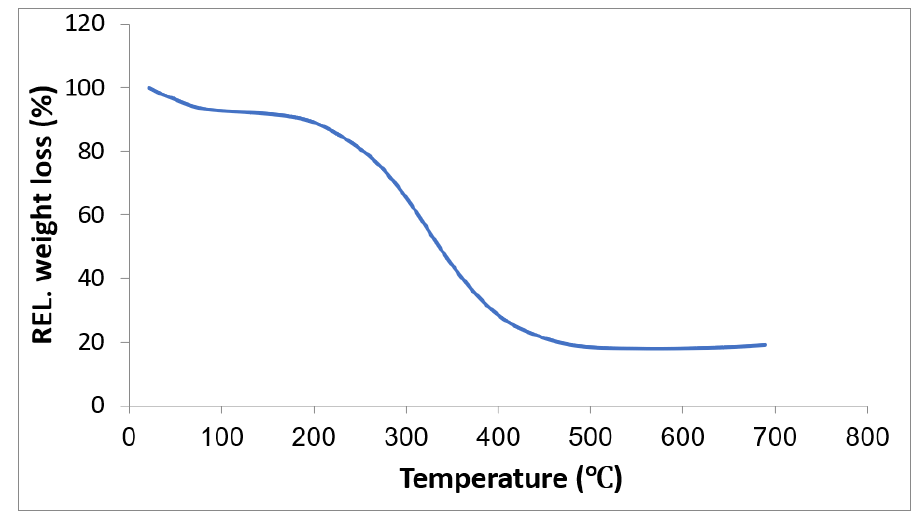
Figure 7. TGA analysis of ARs.